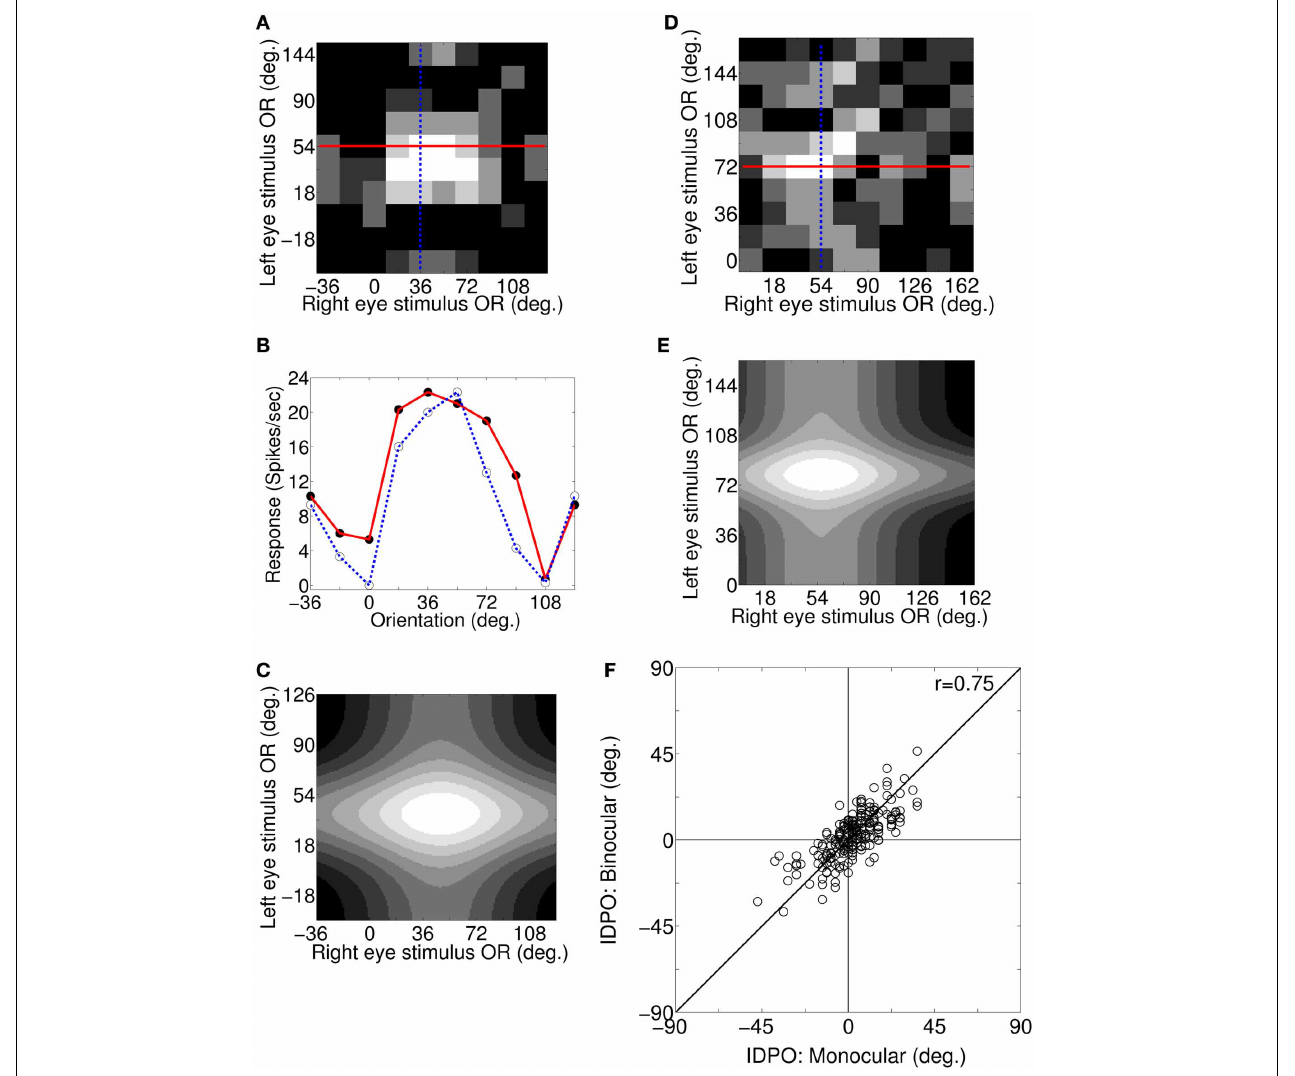
second set (blue dotted curve), OR of the grating to the right eye is fixed at the cell’s preferred OR of 36 ◦ and OR of the applied grating to the left eye is varied. (C) Fitted 2D Gaussian function to the binocular response surface plot for the sample cell in (A) . The peak of the fitted 2D Gaussian function center gives the cell’s binocular IDPO value. The cell’s binocular IDPO is 10 ◦ . (D) Binocular response surface plot for another sample cortical cell. The maximum binocular response of this cell is 29 spikes/s. (E) Fitted 2D Gaussian function to binocular response surface plot for the sample cell in (D) . The cell’s binocular IDPO is 22 ◦ . (F) Scatter plot of monocular IDPO versus binocular IDPO for 210 modeled simple cells. The monocular IDPO and binocular IDPO show strong correlation between them ( r = 0 . 75 , N = 210).